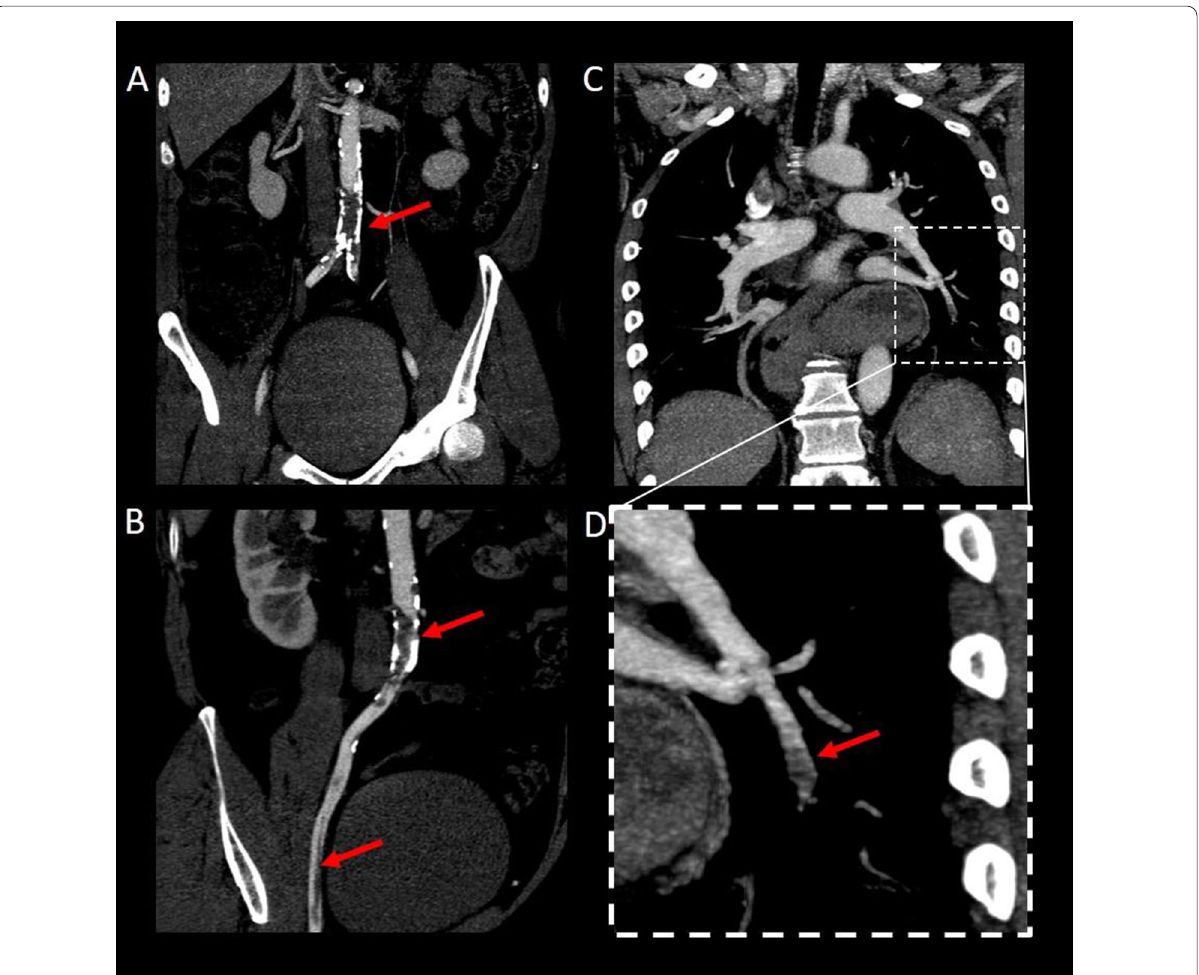
Fig. 2 a Coronal and b curved multiplanar reconstructions of CT-A (in 5 mm maximum intensity projection) display subtotal thrombotic occlusion of infrarenal aorta and extension of thrombus into both common iliac arteries and right external iliac artery. c Coronal multiplanar reconstruction of CT-A (5 mm maximum intensity projection) and d magnified image show segmental pulmonary artery